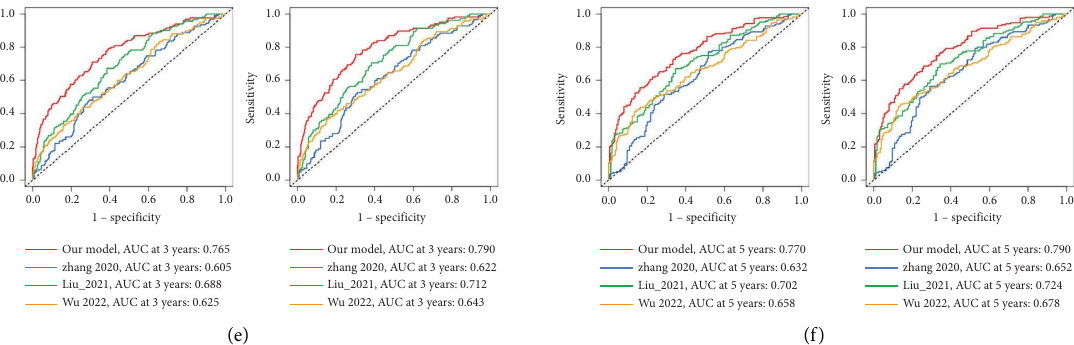
Figure 7: Depth analysis according to the prognostic risk model: (a) bar plots showing the results of functional enrichment analysis based on DRGs, (b) K–M survival analysis of diferent risk patients in training and validation cohort, (c) ROC curves of the predictive efciency of our model in training and validation cohort, and (d–f) ROC curves of the diverse predictive efciency between our model and other published models in training and validation cohorts.